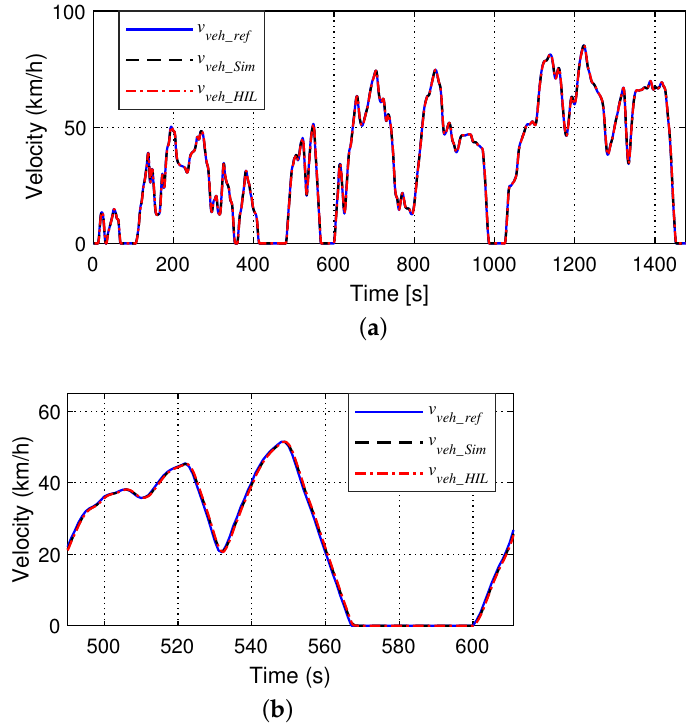
Figure 18. Velocity of the EV in WLTC Class 2 in the signal HIL experiment: ( a ) Full driving cycle; ( b ) Zoom shape.